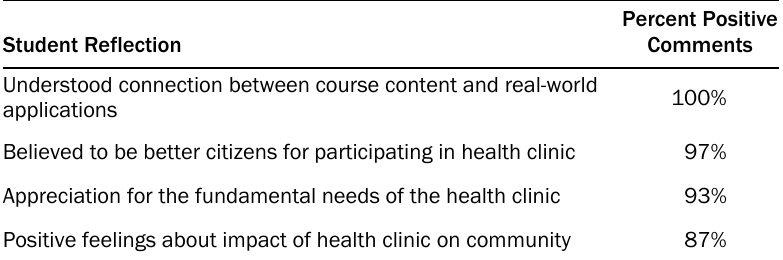
Table 2b. Results of Advanced Physiology Student Reflections (n =